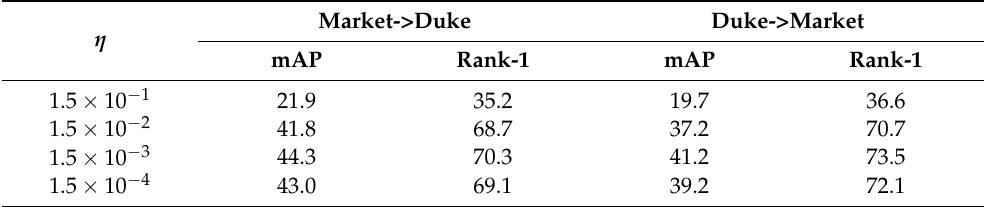
Table 3. Dynamic decreasing rate η